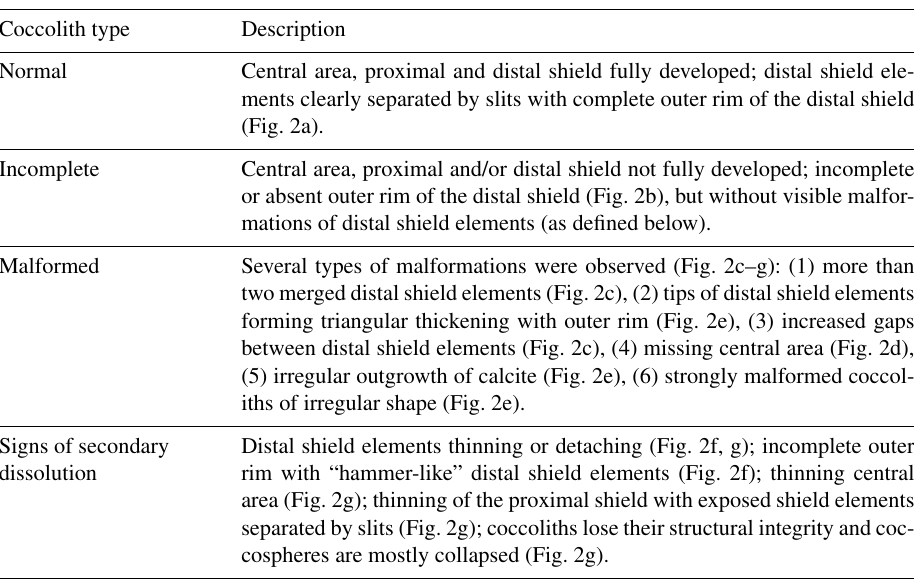
Figure 4. Schematic of the combined effect of P limitation and heat stress in semi-continuous (a, b) and batch culture (c, d) of Emiliania huxleyi . Blue coccoliths represent coccoliths covering cells of control cultures, whereas red coccoliths/crosses denote new/missing coccoliths. The asterisk ( ∗ ) indicates cultures that were undersaturated in calcite. Table 3. Characteristics of the three classes (normal, incomplete, malformed) used to describe coccolith morphology, including a description of “dissolution